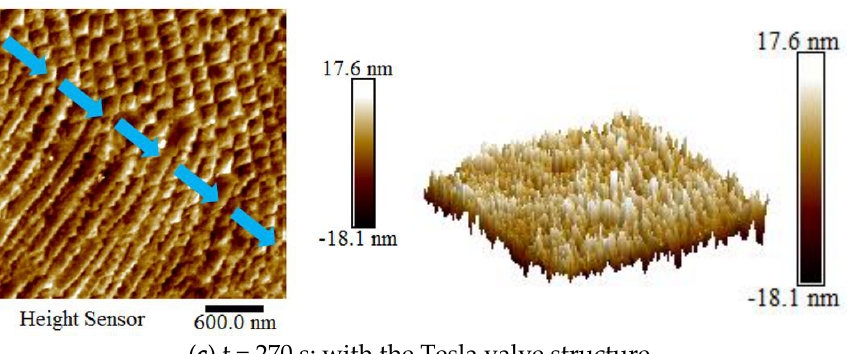
( c ) t = 270 s: with the Tesla valve structure. Figure 16. ( a ) Time = 180 s with the Tesla valve structure; time = 270 s Atomic Force Microscopy (AFM) topography of copper foil ( b ) without the Tesla valve structure and ( c ) with the Tesla valve structure. The blue arrows represents different layers after AFM characterization.